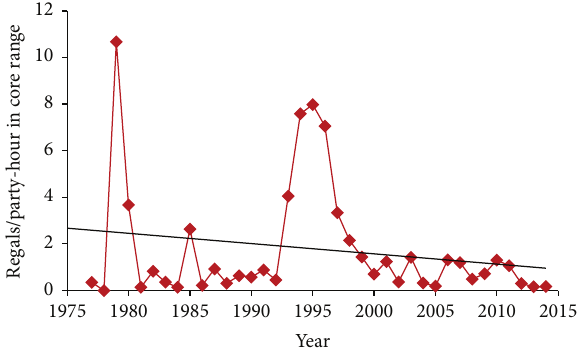
Figure 8: Total Regal individuals divided by number of counts reporting Regal present, 1977–2014, with regression trend line and three-year running average. The three counts in the highest order of magnitude abundance category (Table 4) were held in 1993–99 (but in no year were all three counts held) with one also reporting in 2002. This was weakly positive but far from significant in 1977–2014; the decline was significant in 1991–2014 (Table